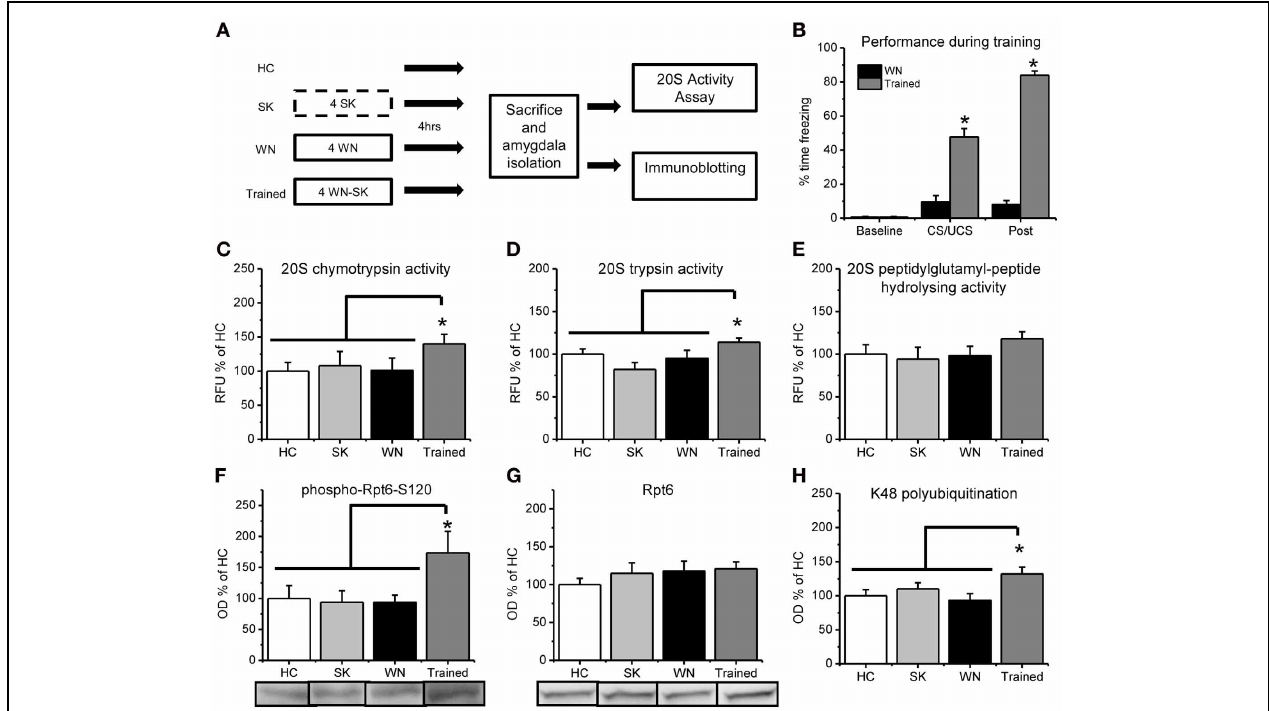
alone. (C–E) Proteasome chymotrypsin-like (C) trypsin-like (D) and peptidylglutamyl-peptide hydrolyzing-like (E) activities were increased only in rats that received the auditory cue paired with the footshock. (F) Fear conditioning increased phosphorylation of the proteasome regulatory subunit Rpt6 at Serine120 (G) There were no increases in the Rpt6 subunit but (H) fear conditioned animals showed enhanced protein polyubiquitination. ∗ p < 0 . 05 from WN controls (B) or HC, SK and WN controls (C–H)